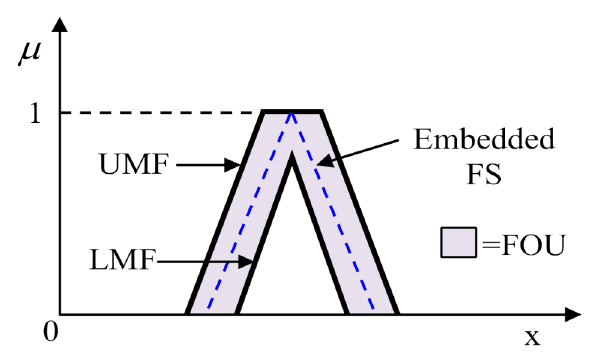
Figure 3. Type-2 fuzzy logic sets with footprint of uncertainty (FOU) and embedded fuzzy set